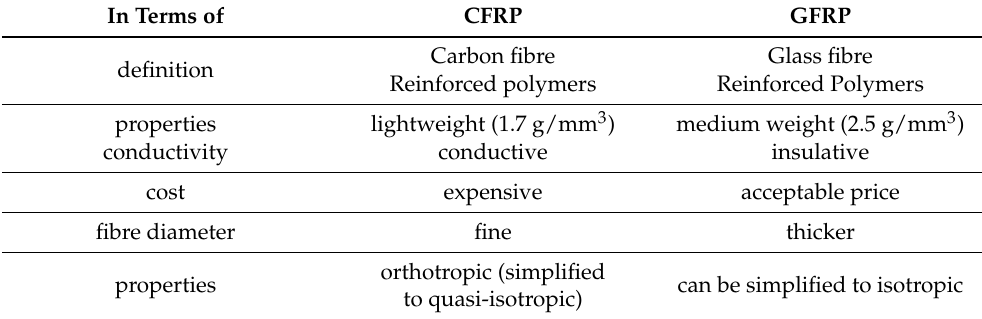
Table 2. CFRP versus